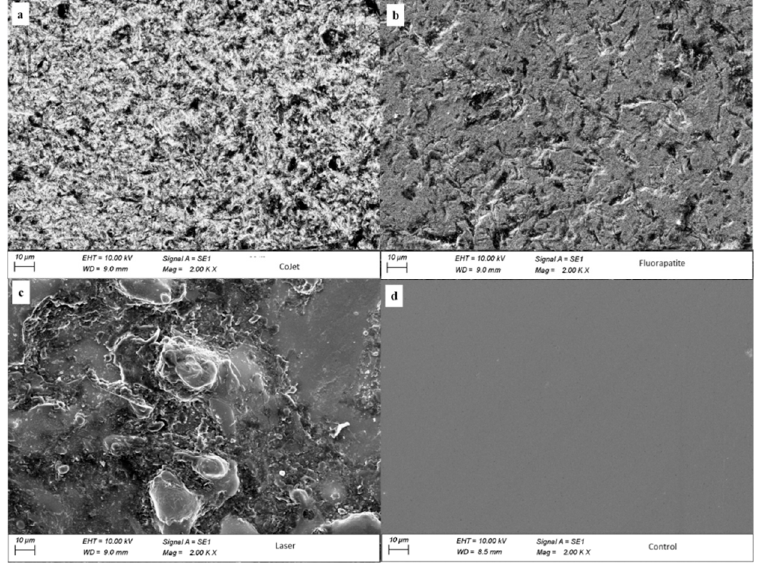
Figure 6 . Scanning electron microscope images 2000× showing an extensive irregular surface of the CoJet group ( a ), less irregular surface with scattered grooves in FGC group ( b ), blister-like deformities in FGC + Nd: YAG ( c ), and plain smooth surface in the control group ( d ).